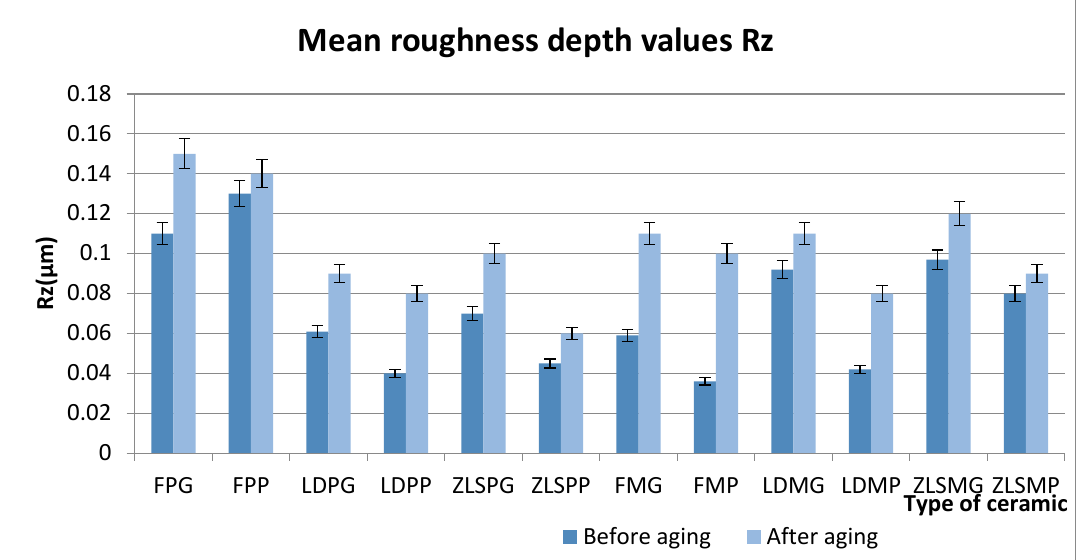
Figure 4. Mean values for the Rz parameter before and after thermocycling for the hot-pressed and milled ceramics.